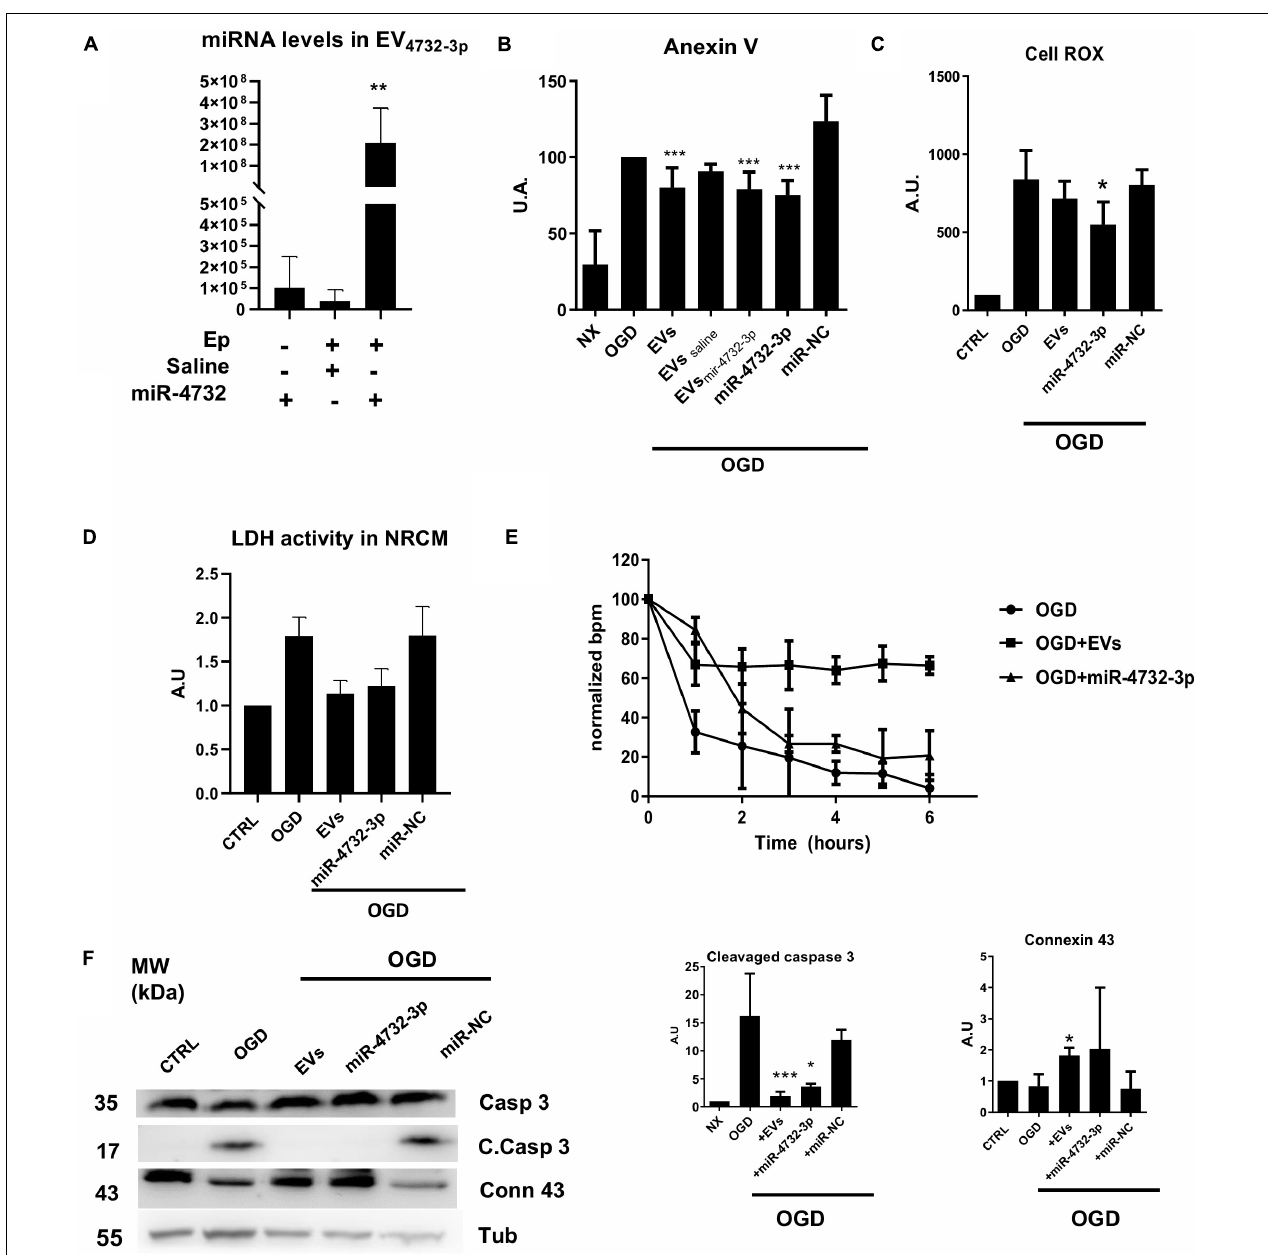
FIGURE 2 | Effect of EVs and miR-4732-3p treatment in NRCM. (A) Quantification of miR-4732-3p levels in electroporated EVs (Ep = 3 pulses of 300V) with 40 nM miRNA or saline in the electroporation buffer ( n = 3, * p < 0.05, ** p < 0.01). (B) Effect of EVs on NRCM treated with oxygen and glucose deprivation (OGD) for 6 h. NRCM were treated with 30 µ g/mL of EVs without electroporation (EVs), EVs electroporated with saline (EVs saline) or EVs electroporated with 20 nM miRNA hsa-4732-3p (EVs4732-3p). In addition OGM-treated NRCM were transfected with miR-4732-3p in max suppressor reagent (see section “Materials and Methods”) (miR-4732-3p) ( n = 3, *** p < 0.001). (C) Quantification of ROS by Cell Rox kit measured in cardiomyocytes under OGD and treated with 30 µ g/mL of EVs (EVs)transfected with 20 nM miR-4732-3p (miR-4732-3p) or 20 nM of miR-Negative control (miR-NC) ( n = 3, * p < 0.05). (D) Relative quantification of lactate dehydrogenase activity (LDHA) measured by the absorbance in cardiomyocytes after OGD ( n = 3). (E) Relative quantification of the contraction capacity of the cardiomyocytes in vitro during the OGD episode. (F) Representatives western blot images of cleavaged caspase 3 (C. Cas3) and connexin 43 (Conn 43) and α tubulin (Tub) ( n = 3, * p < 0.05 and *** p <